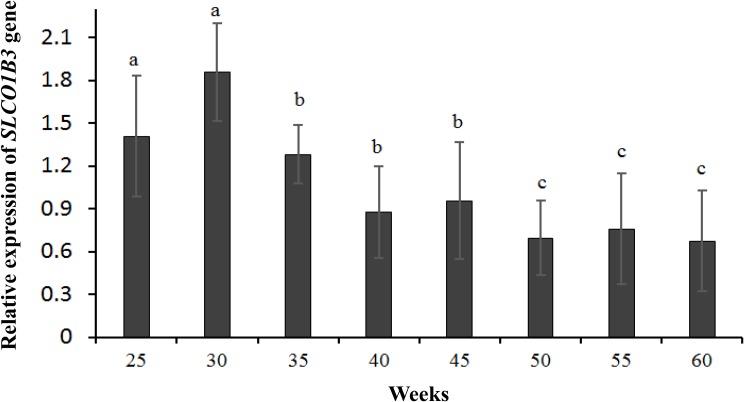
The expression of the SLCO1B3 gene in the shell gland of Lushi blue eggshell chickens at different weeks. Different lowercase letters indicate P < 0.05, and the same letters indicate no difference (P > 0.05).